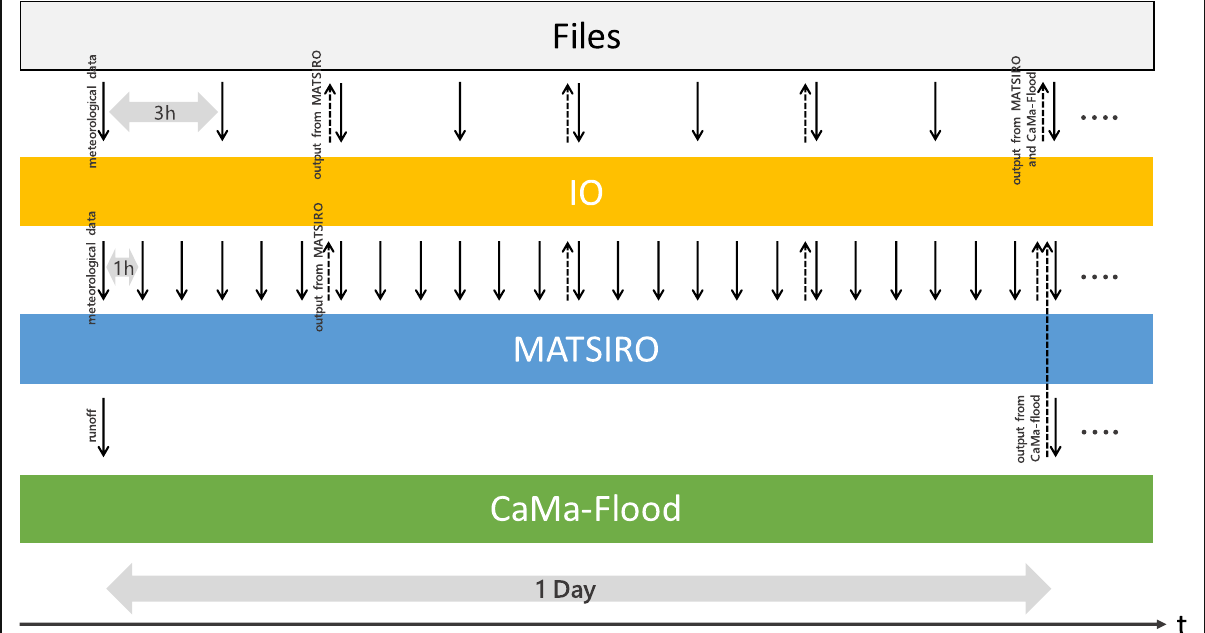
Fig. 7 The computational flow of a global experiment with MATSIRO, CaMa-Flood, and IO components, executed with the MPMD